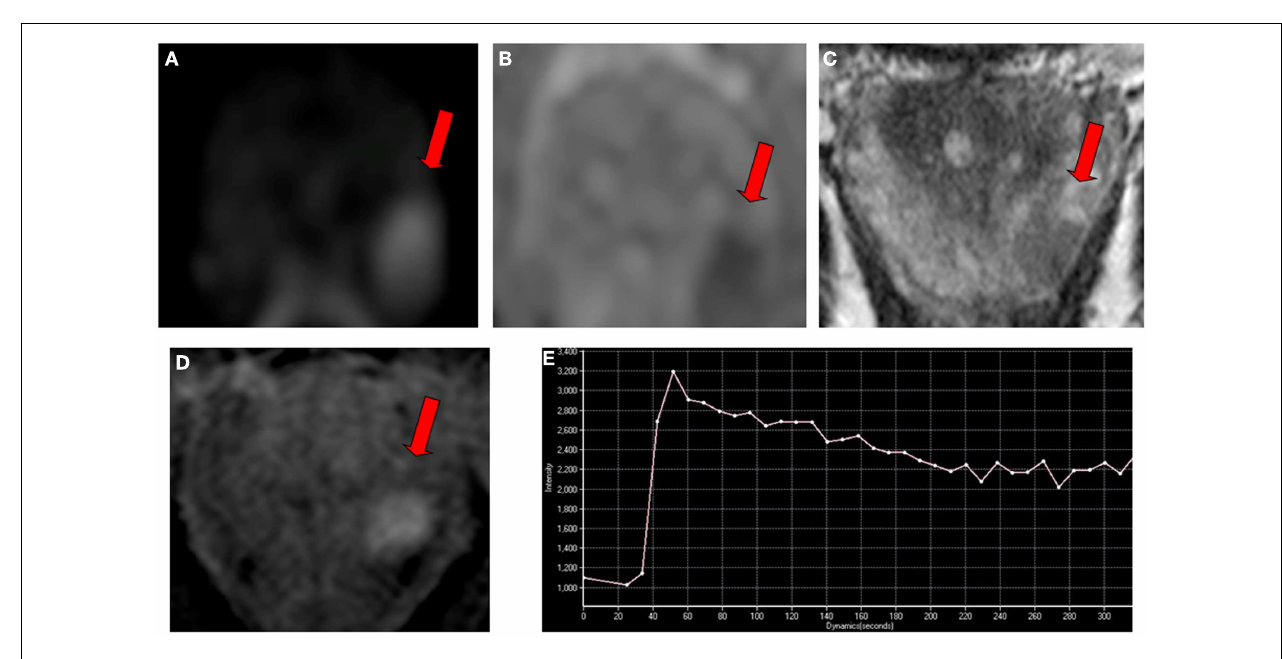
(arrow) corresponded to hypointense lesion on apparent diffusion coefficient map. (C) The lesion (arrow) also corresponded to axial T2-weighted image with low signal intensity, and to (D) focal enhanced lesion on axial dynamic contrast-enhanced imaging with a type 3 enhancement curve (washout) (E) .The final Prostate Imaging Reporting and Data System score for this lesion was four.The presence of a clinically significant cancer was confirmed with a targeted biopsy, showing an 8-mm Gleason score 4 + 3